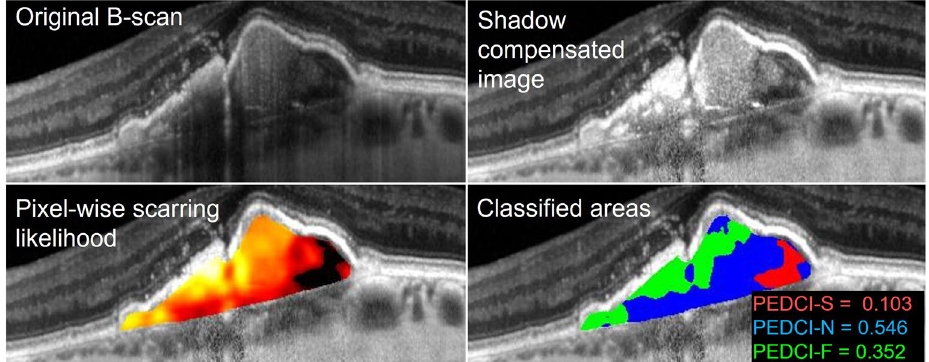
Figure 2. Classification of pixels within a pigment epithelial detachment (PED) of a patient with neovascular age-related macular degeneration. The original B-scan was taken using spectral domain optical coherence tomography. Results from subsequent shadow compensation and computed per-pixel scarring likelihood are shown. Classified areas include serous (red), neovascular (blue), and fibrous (green) components of the PED. Classified areas were used to compute the PED composition indices: serous (PEDCI-S), neovascular (PEDCI-N), and fibrous (PEDCI-F).